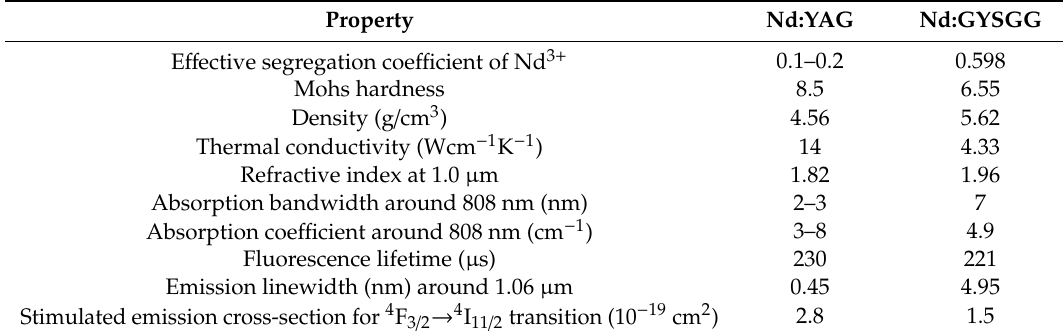
Table 1. Comparison of main physical and optical properties of Nd:YAG and Nd:GYSGG [4–7]. Property Nd:YAG Nd:GYSGG E ff ective segregation coe ffi cient of Nd 3